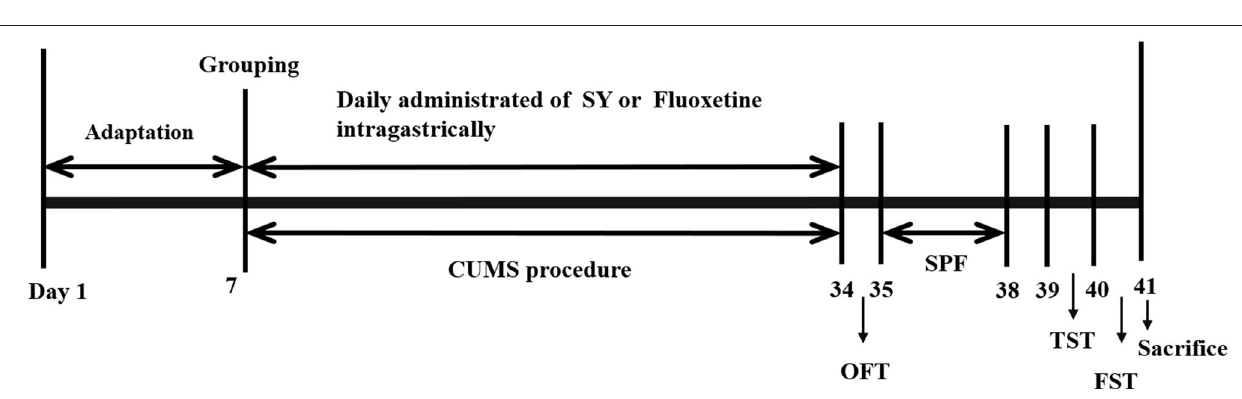
FIGURE 2 | Experimental design